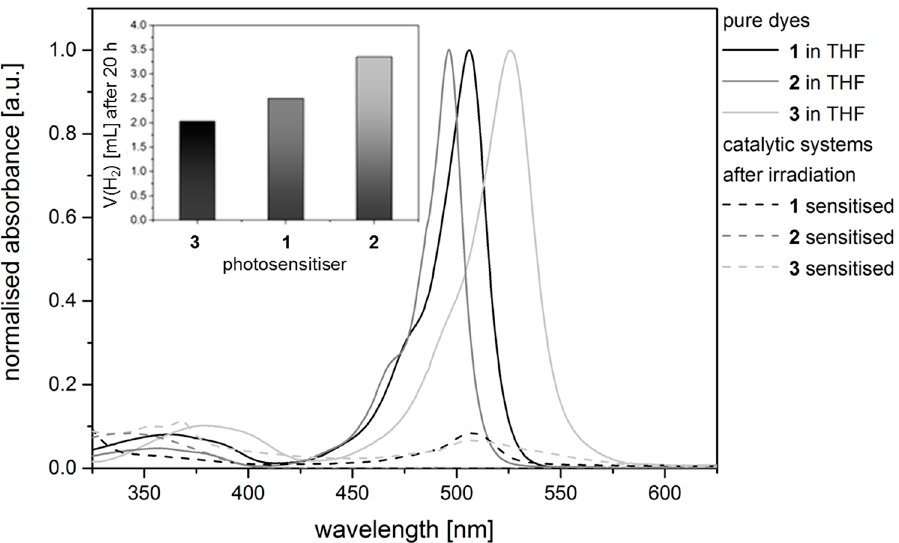
Figure 4. Absorption spectra of pure BODIPY dyes 1 , 2 , and 3 before (solid lines) and after (dashed lines) utilisation in a multicomponent catalyst system.